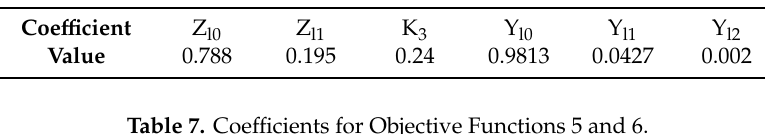
Table 6. Coe ffi cients for Objective Functions 3 and 4.